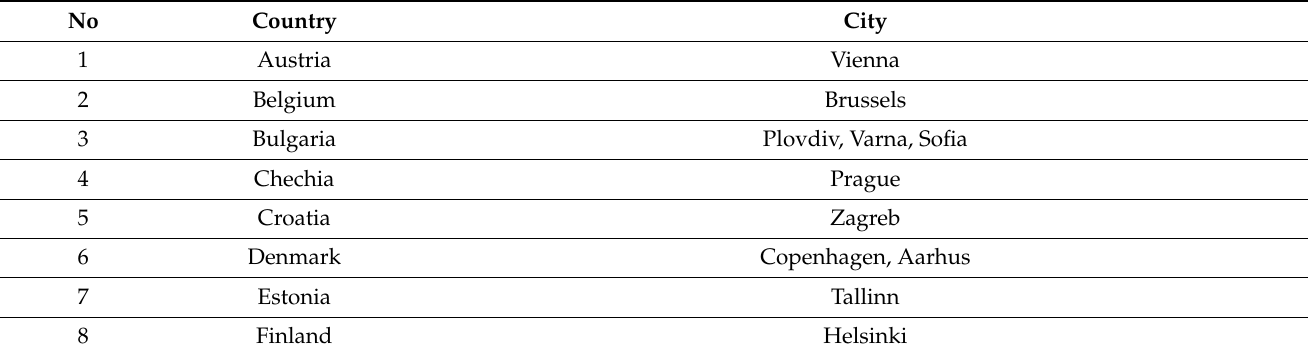
Table 1. List of the cities included in the study with division in